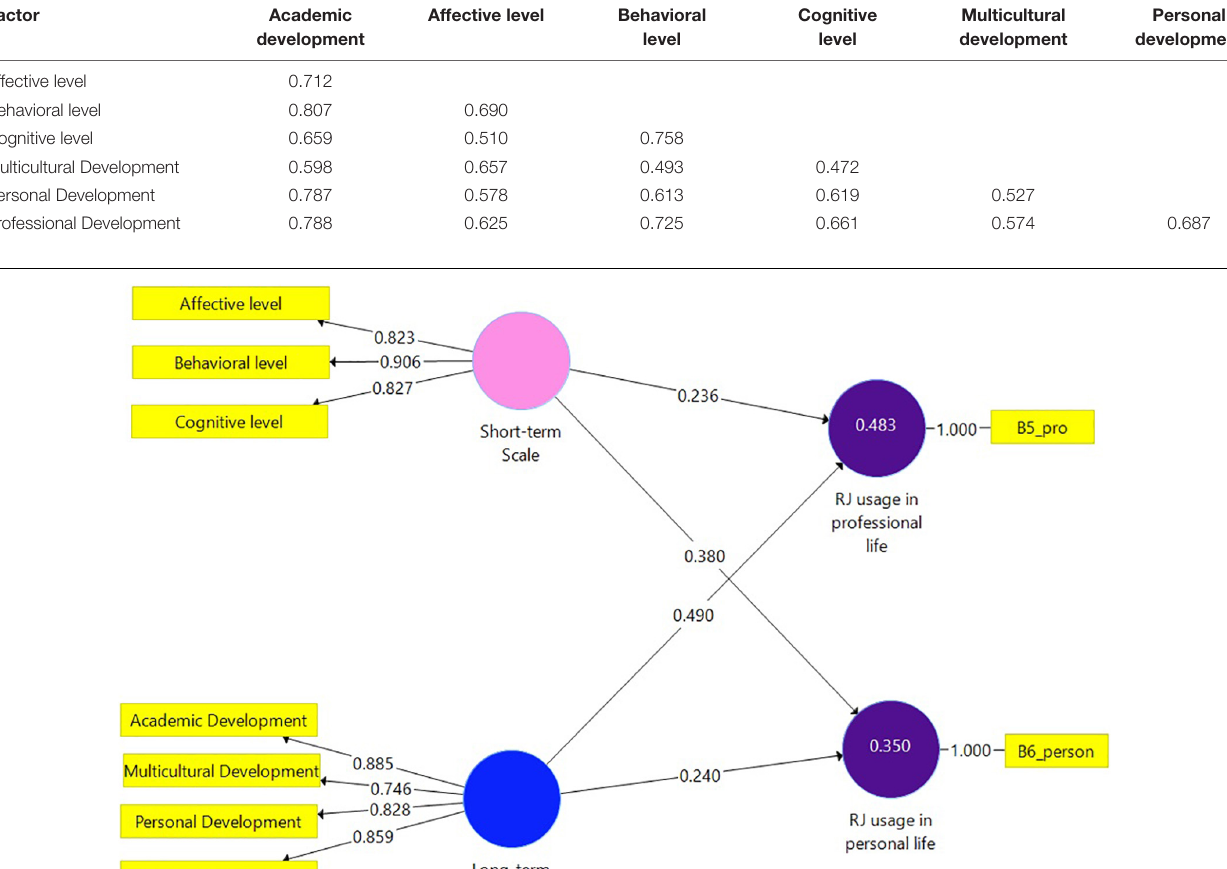
TABLE 4 | Results of discriminant validity by using the heterotrait-monotrait (HTMT) ratio of correlation ( N = 141).